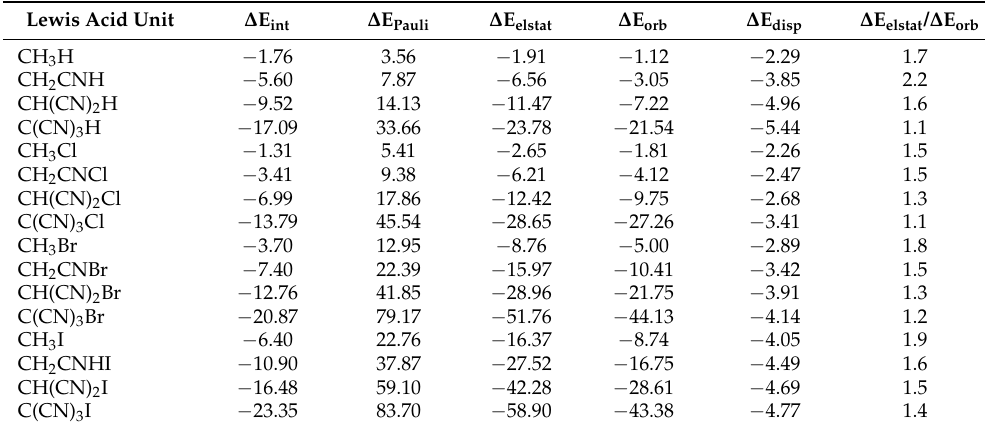
Table 10. The interaction energy terms (in kcal/mol) and the ∆ E orb / ∆ E elstat ratio for